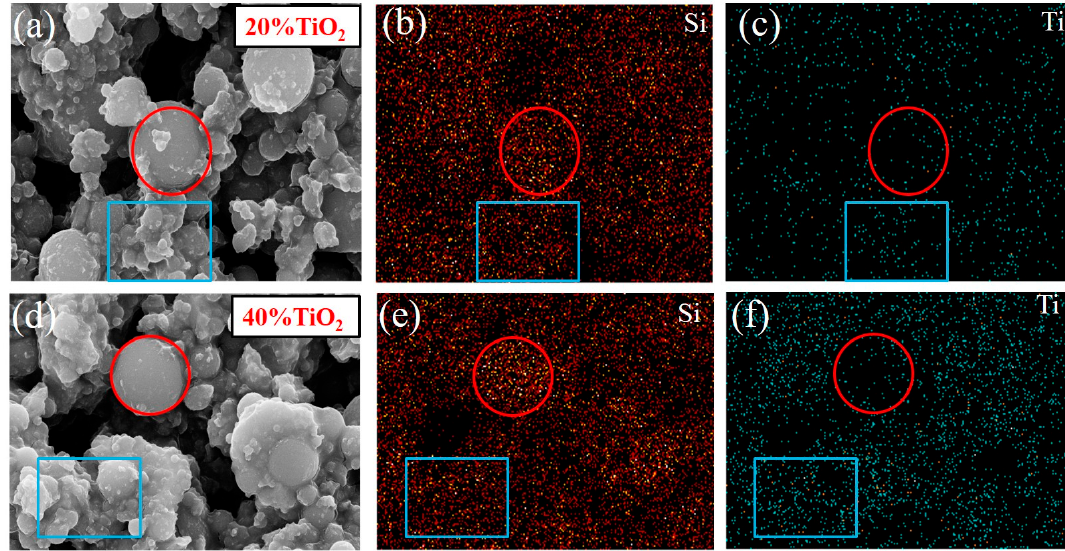
Figure 7. Scanning results of surface elements of SiO 2 –TiO 2 with ( a – c ) 20% TiO 2 and ( d – f ) 40% TiO 2 .